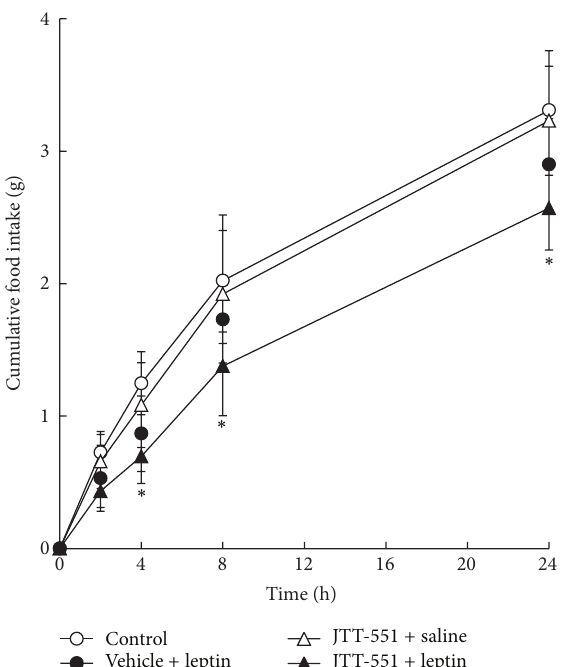
Figure 1: Enhancement effect of JTT-551 on leptin suppressed calorie intake in DIO mice. Data represent mean ± SD ( 𝑛 = 5 ). ∗ 𝑃 < 0.05 : significantly different from the control by Dunnett’s test (two-tailed).